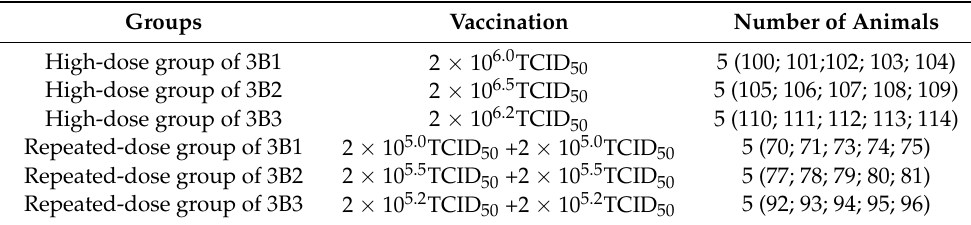
(Table 1). Another fifteen PRRSV-free piglets that used to assess the safety of repeated- dose immunization of three batches of laboratory products were randomly divided into three groups (3B1–3B3) and separately immunized at 0 days post-vaccination (dpv) and 14 dpv (Table 1). Each group of piglets was maintained in individual biosafety room. Clinical signs and rectal temperatures were recorded daily. Blood samples were periodically collected from individual piglets and tested for viremia. All of the piglets of the high-dose group of 3B1–3B3 were euthanized at 14 dpv. Ten tissue samples were obtained from the hearts, livers, spleens, lungs, kidneys, lymph nodes, tonsils, small intestines, bladders, and stomachs for viral detection by TaqMan ® -based real-time fluorescence quantitative RT–PCR [55]. Table 1. Group information for safety evaluation of SD-R. Groups Vaccination